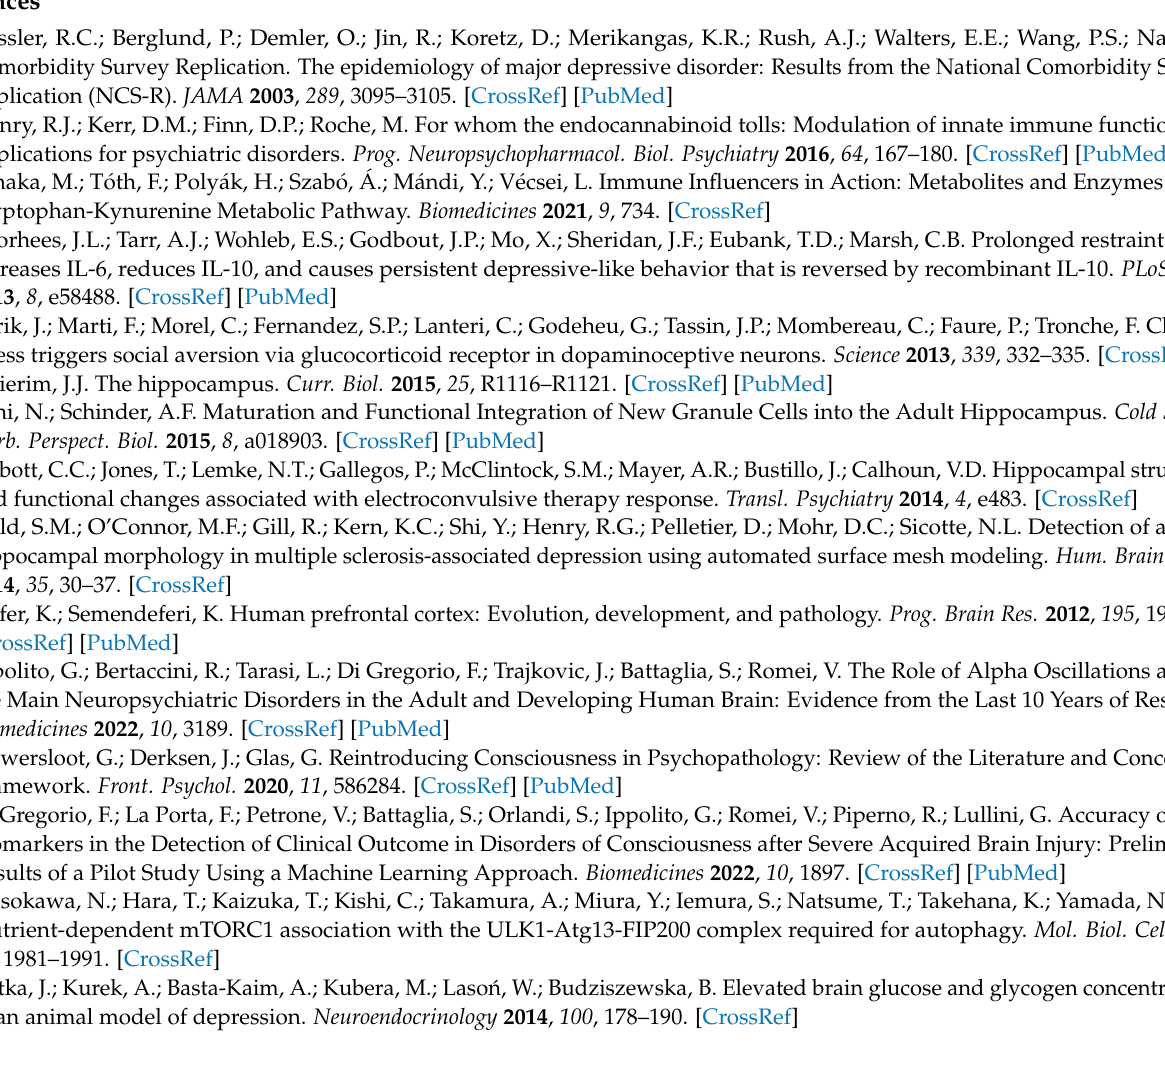
Table S3. Effect of rosiglitazone on brain glycolytic enzymes; Table S4. Effect of rosiglitazone